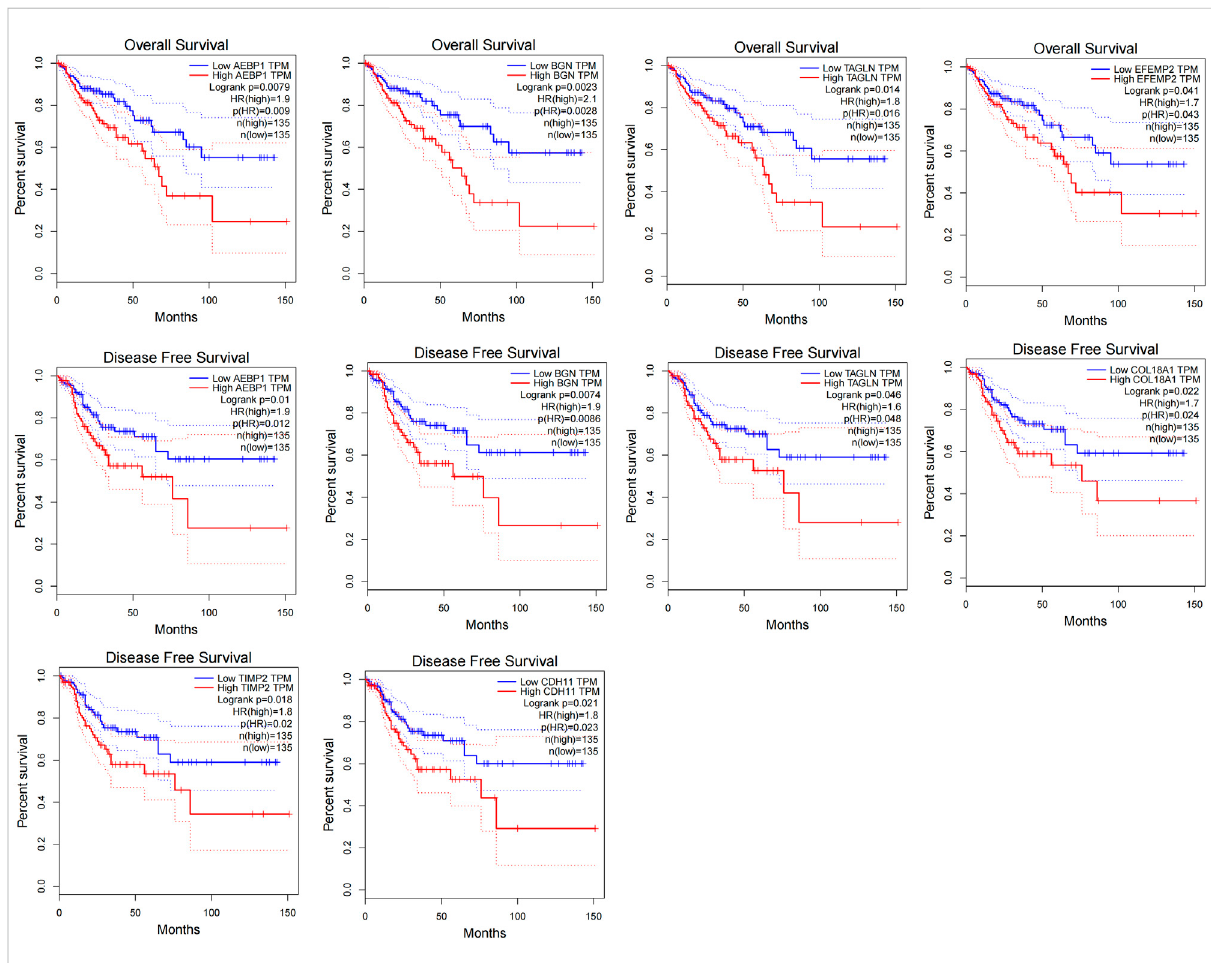
FIGURE 10 Disease-free survival analysis and overall survival of the 13 key node genes in colon cancer based on the